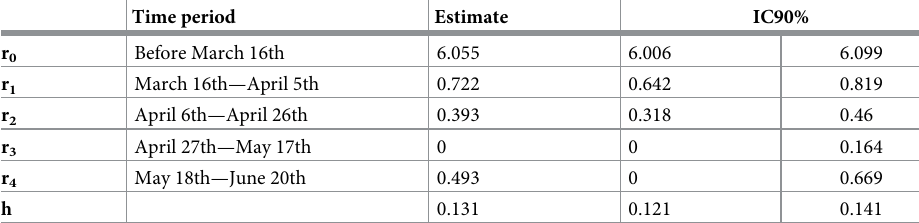
Table 3. Estimates of the unknown parameters of the SI 2 R 2 D model with 90% confidence intervals.